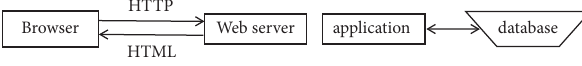
Figure 8: Four-tier architecture of